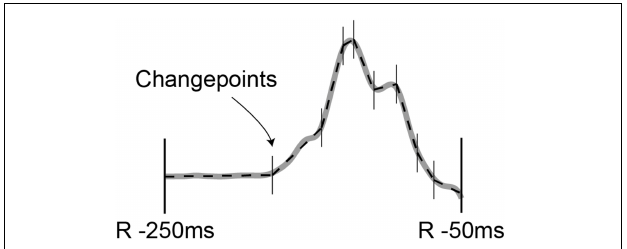
FIGURE 2 | Averaged P-wave reconstruction by linear fits using MATLAB’s findchangepts algorithm.